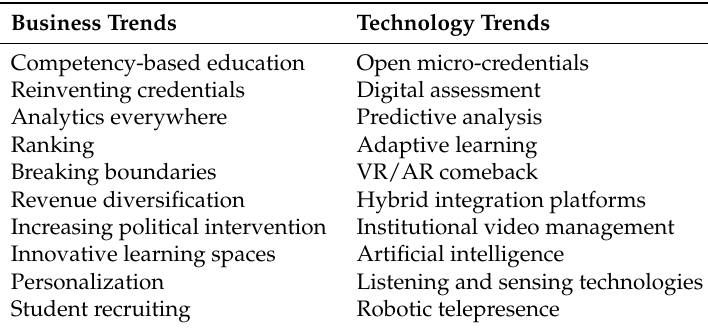
Table 2. Business and technology trends on higher